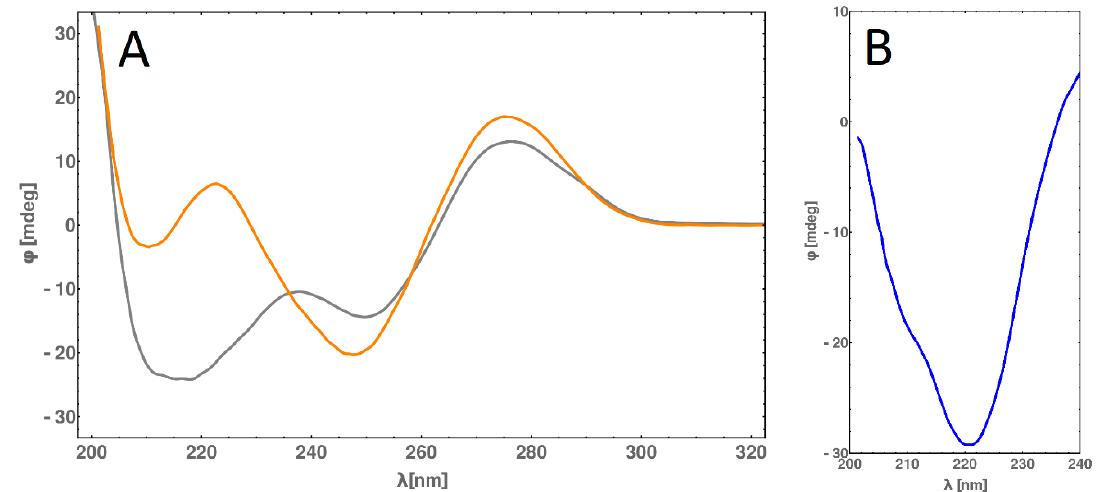
Figure 8. ( A )—Circular dichroism spectra obtained for dsDNA (in orange) and dsDNA*-PEP (gray) at 25 ◦ C. ( B )—The “di ff erence” circular dichroism spectrum obtained for dsDNA*-PEP at 25 ◦ C. The resulting spectrum represents the di ff erence between dsDNA*-PEP and dsDNA CD spectra, rescaled by the concentration of the sample. Far-UV CD was measured on a Jasco J-810 spectropolarimeter (Jasco, Tokyo, Japan). Experiments were performed in 100 mM TBA bu ff er, pH 8 in 1 mm pathlength cuvette. The sample concentrations were 0.25 and 0.4 mg / mL for dsDNA-PEP and dsDNA, respectively. Spectra were recorded from 190 to 350 nm with a 1 nm step